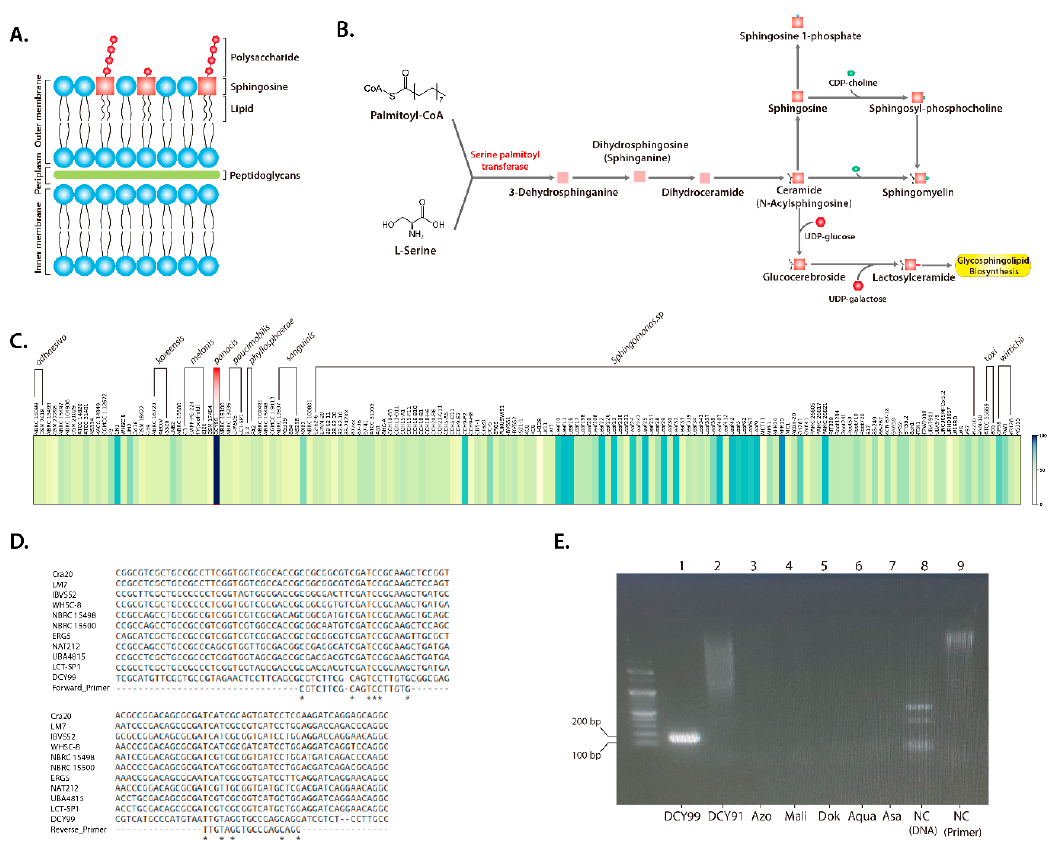
Figure 6. ( A ) LPS-free gram-negative bacterial cell wall structure of Sphingomonas species. ( B )